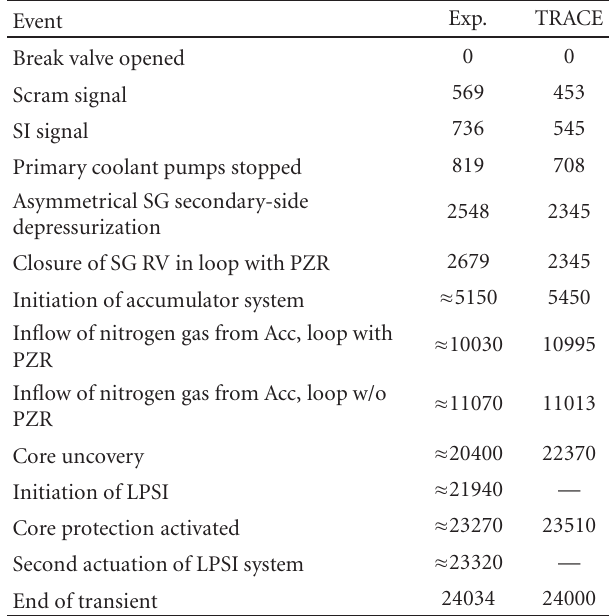
Table 5: Chronology of the main events in Test 6-2